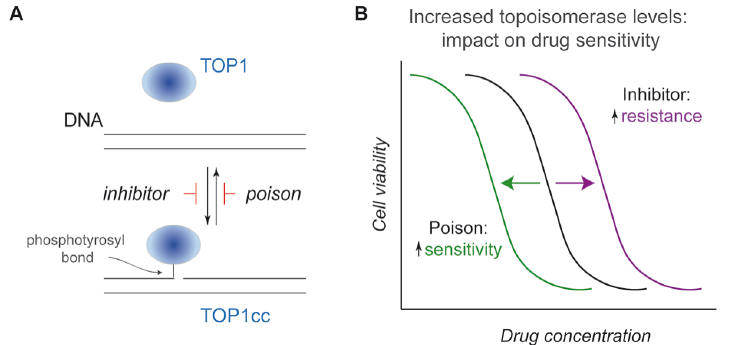
Figure 2. Distinct actions of topoisomerase poisons and inhibitors. ( A ) As diagrammed for TOP1, a canonical inhibitor would prevent enzyme-mediated cleavage of a single strand of duplex DNA, while a poison (such as camptothecin) acts to stabilize the topoisomerase I cleavage complex (TOP1cc) reaction intermediate, thereby converting a normal enzyme into a source of DNA damage. The same principles apply to TOP2, although, in these instances, the dimeric enzymes produce two enzyme-linked DNA breaks staggered by 4 bp. ( B ) Based on these distinct modes of action, increased topoisomerase levels in an isogenic cell line would induce opposing effects on drug sensitivity: resistance to an inhibitor versus increased sensitivity to a poison. Shown in this diagram are the dose response curves for killing that result from an increase in topoisomerase levels relative to cells that yield the black